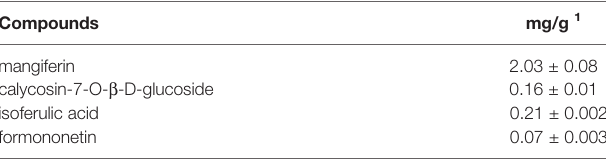
TABLE 1 | Amounts of bioactive compounds in